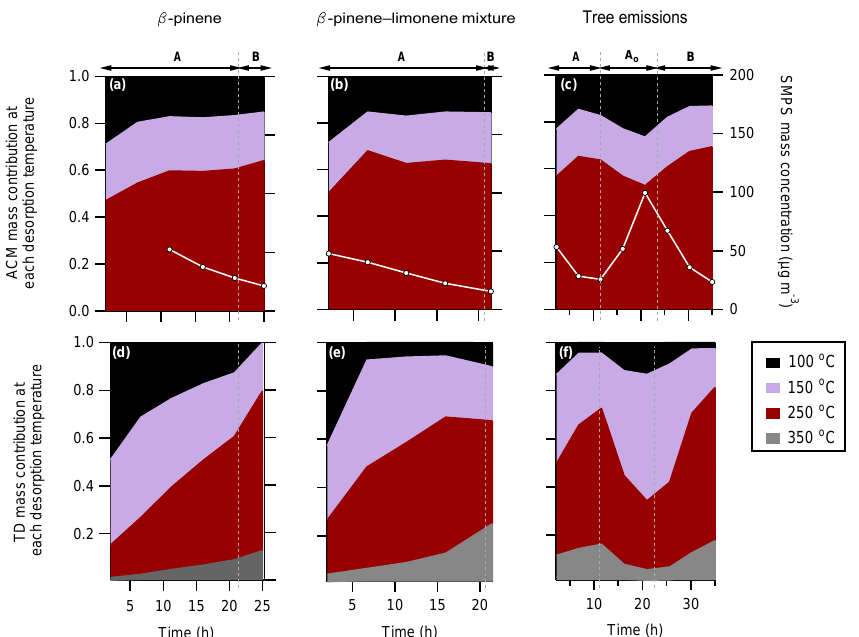
Figure 5. Temperature-dependent mass concentration contribution (left y axis) of ACM (upper plots: a , b , c ) and TD (lower plots: d , e , f ) for β -pinene (a, d) , β -pinene–limonene mixture (b, e) and real tree emissions (c, f) versus the time since ozone injection ( x axis). White lines and circle markers (right y axis) represent the SMPS mass concentration during each experiment. Dash vertical lines indicate the different experimental periods with A: the ozonolysis and SOA formation period; B: the chamber illumination and photo-oxidation period; and A 0 : the re-injection of tree BVOCs to the SAPHIR